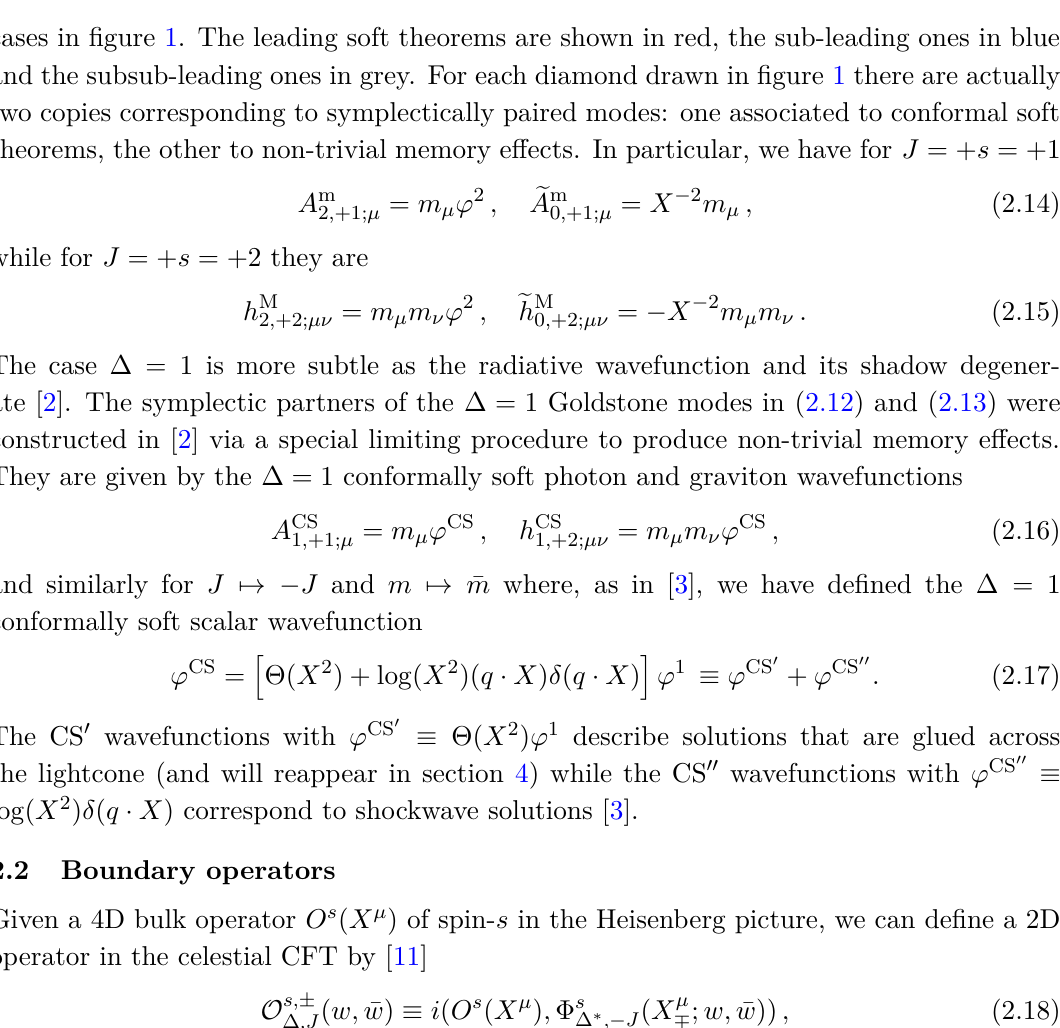
Figure 1. Celestial diamonds for the conformally soft (a) photons and (b)